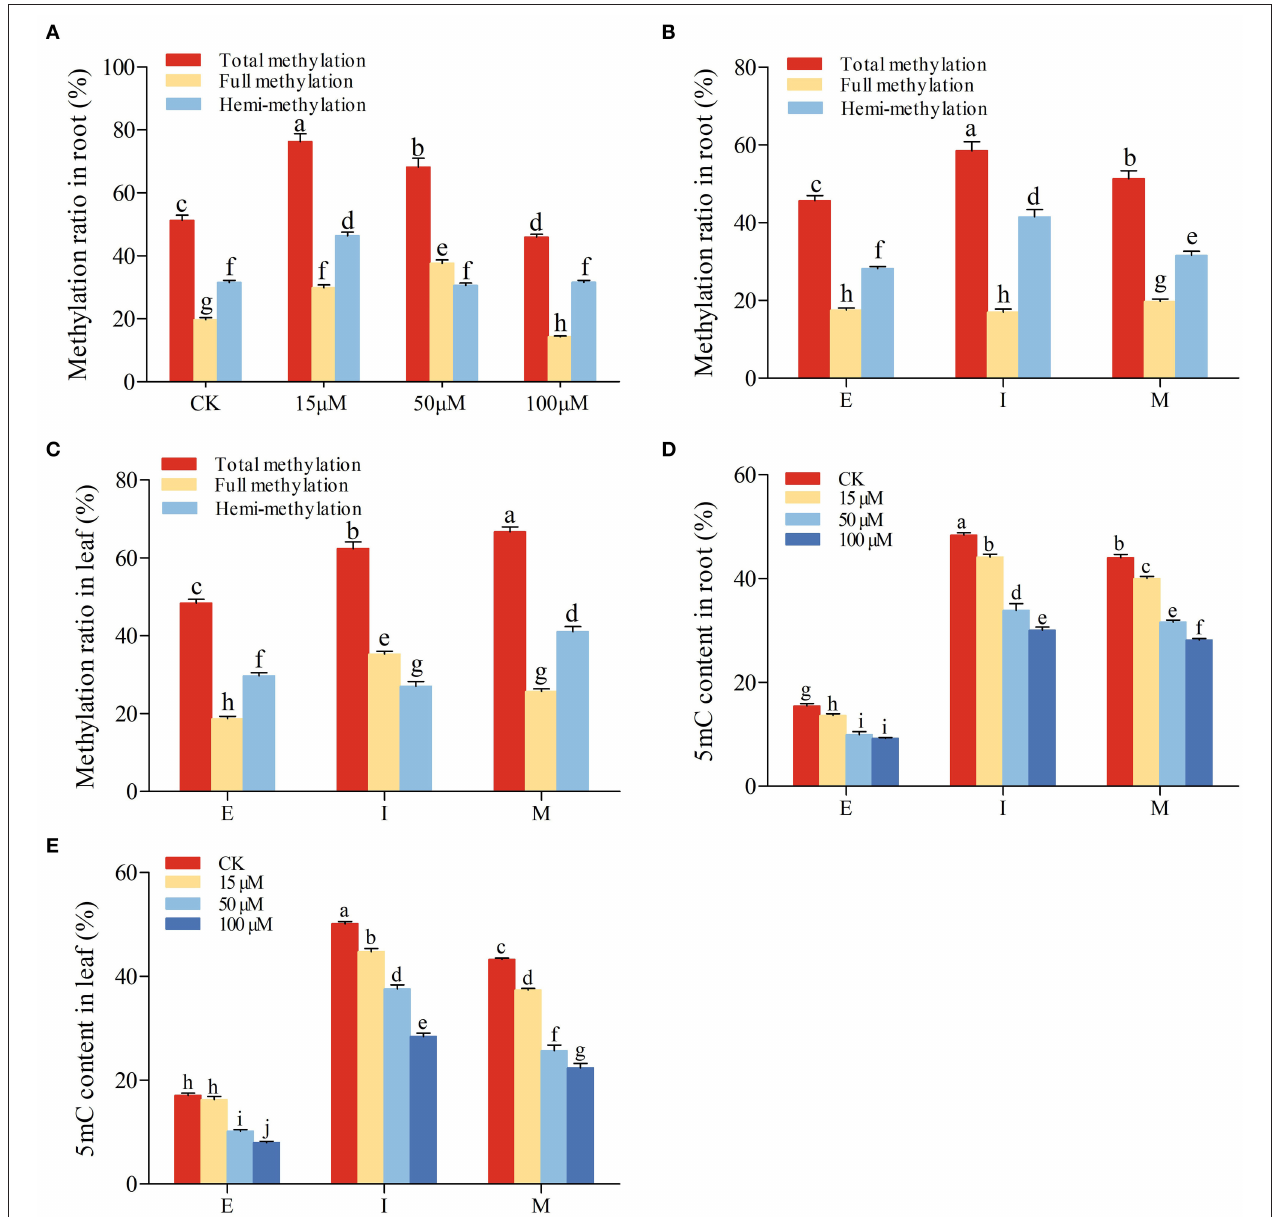
FIGURE 7 | Genomic DNA methylation in R. glutinosa . (A) Methylation ratio in root at M stage under 5-azaC treatment. (B,C) represent methylation ratio in root or leaf of R. glutinosa ; (D,E) represent 5mC content in root or leaf of R. glutinosa under 5-azaC treatment. E, I, and M represent elongation stage, intumescent stage, or maturation stage of R. glutinosa , respectively. The error bar is standard error of mean, and the lower letter above the bar indicates the significant difference ( P <